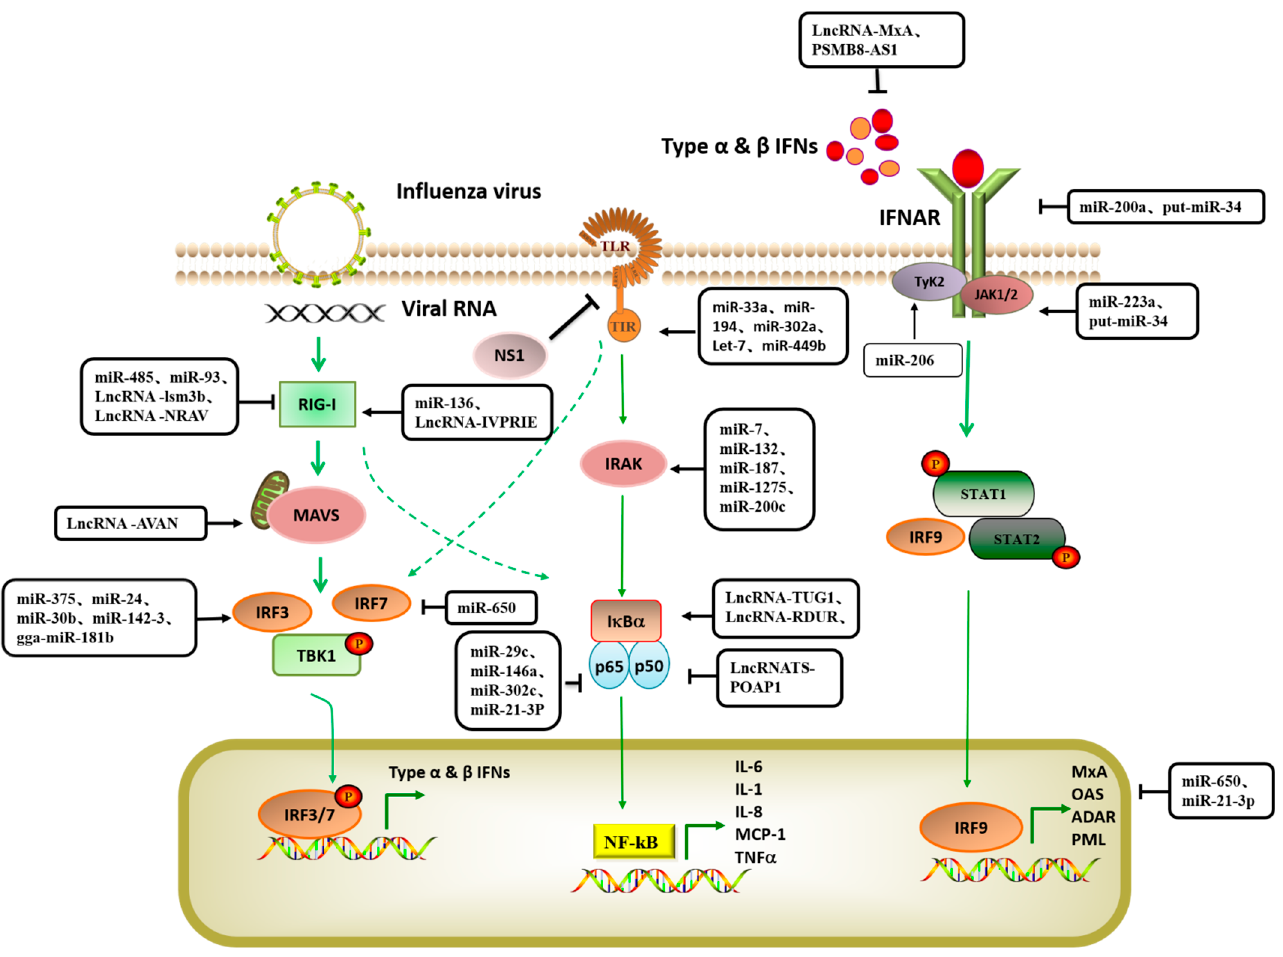
Figure 1. Host noncoding RNA involved in regulating influenza A virus response signal